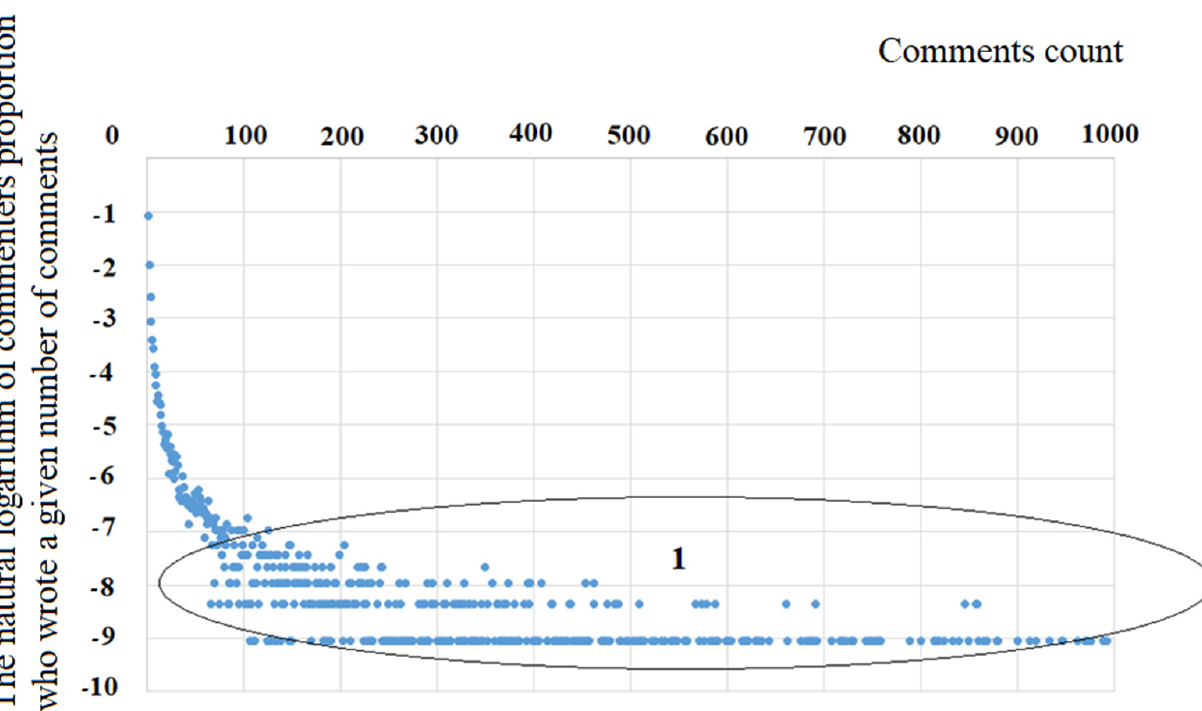
Figure 3. Linearization of observed data for exponential distribution .